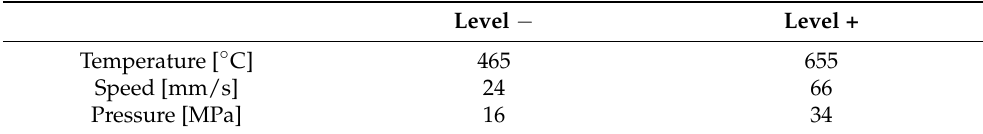
Table 1. Control Factors levels.